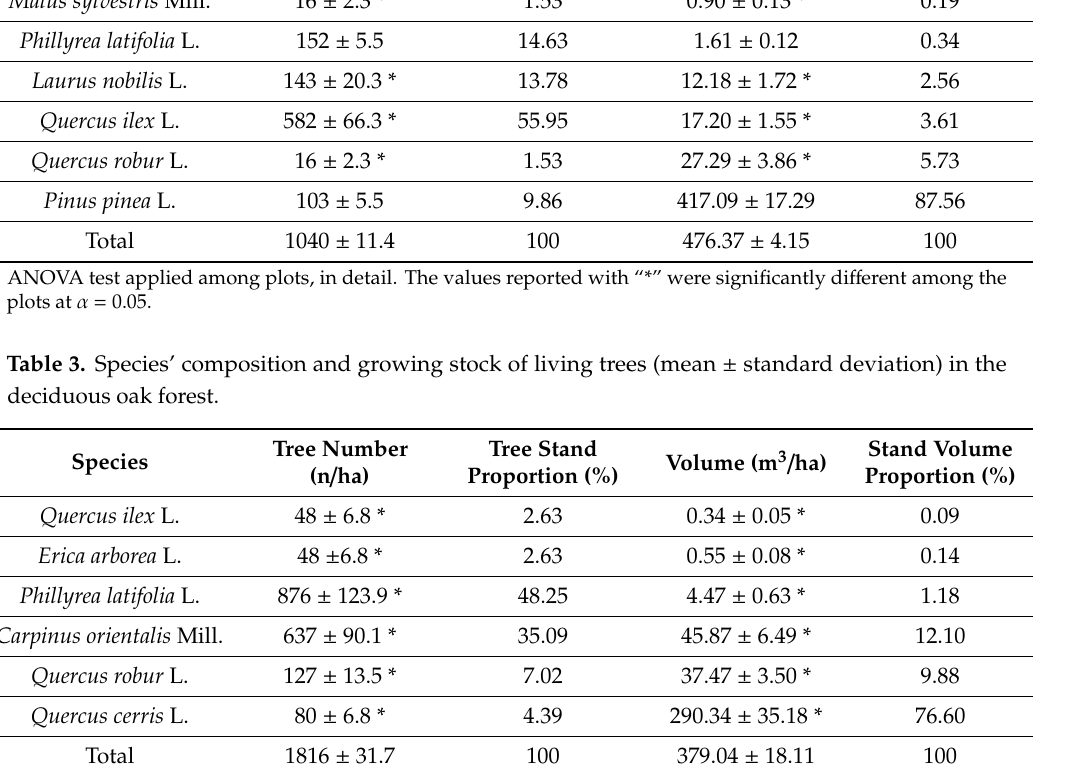
Table 2. Species’ composition and growing stock of living trees (mean ± standard deviation) in the pine forest. Stand Volume Tree Number Tree Stand Species Volume (m 3 / ha) Proportion (%) (n / ha) Proportion (%) Pistacia lentiscus L. 28 ± 4.0 * 2.72 0.10 ± 0.01 * 0.02 Malus sylvestris Mill. 16 ± 2.3 *